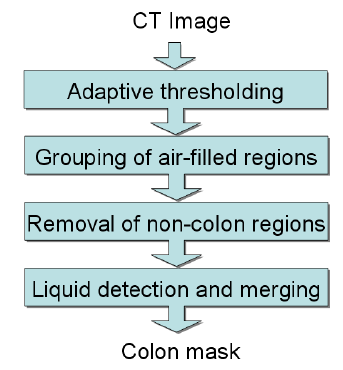
Figure 2. Block diagram for the colon